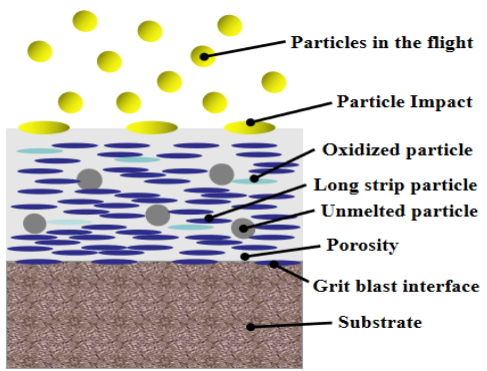
Figure 3. Schematic diagram of particle deposition.